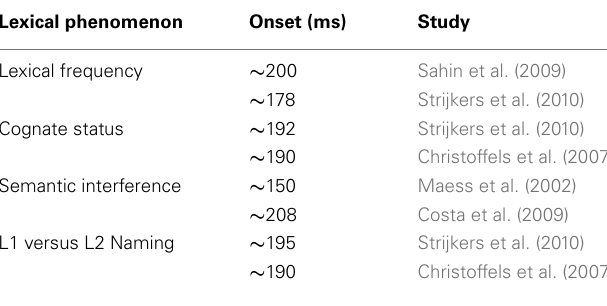
Table 1 | Overview of lexical variables and their time course reported in ERP studies of immediate